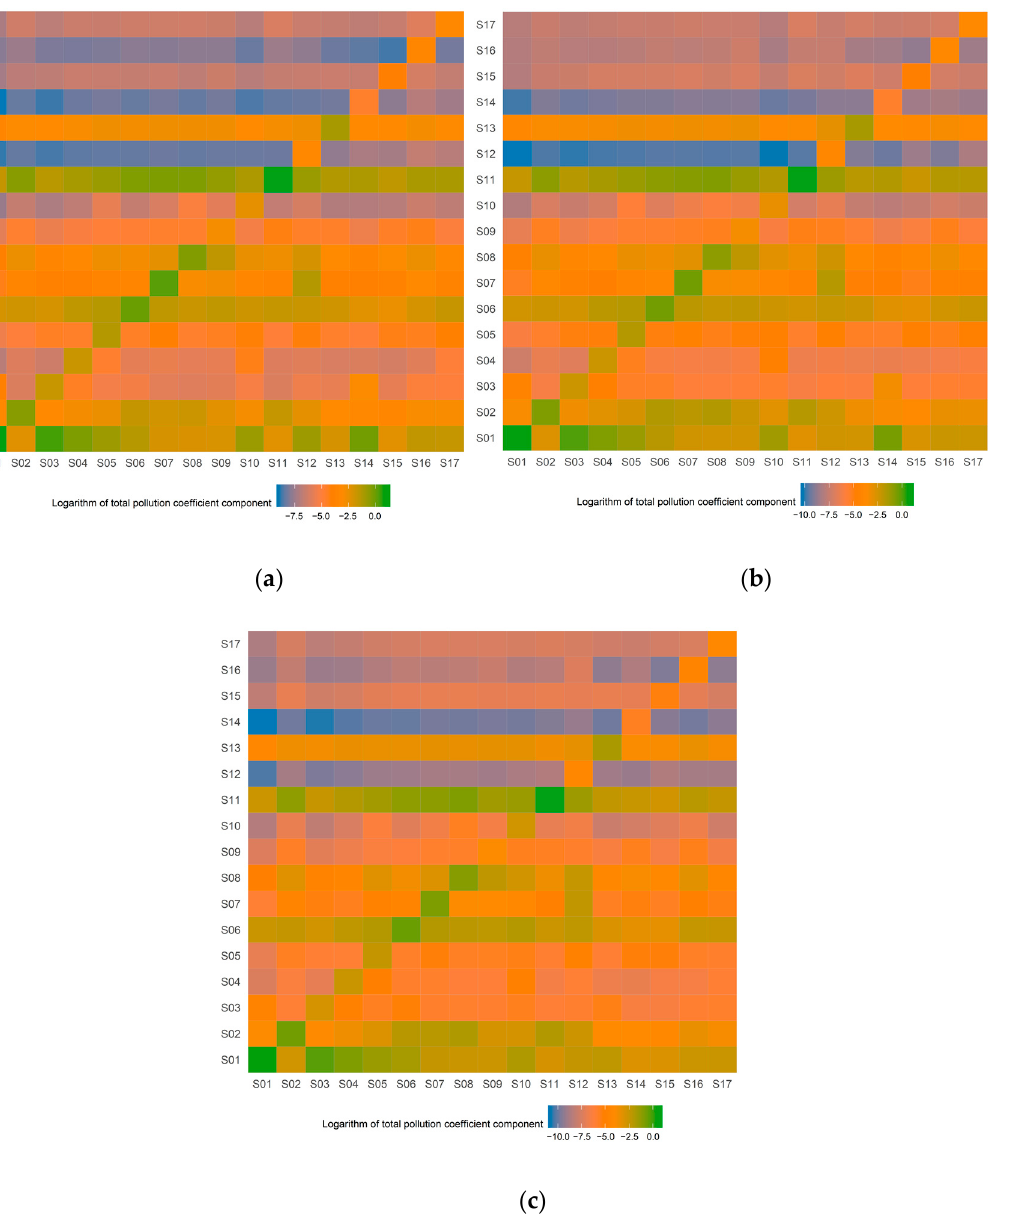
Figure 4. The logarithm of China’s TPCC matrix of the EF in 2005 ( a ), 2010 ( b ), and 2015 ( c ).